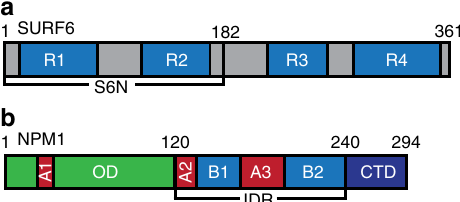
Fig. 1 Structural features of NPM1 and S6N. a SURF6 is a disordered protein which consists of four arginine-rich motifs (R-motifs), R1 – R4 (blue). An N- terminal construct (S6N; residues 1 – 182), which includes two of the R- motifs, R1 and R2, was used in this study. b NPM1 is comprised of an oligomerization domain OD (green), a long intrinsically disordered region (IDR) spanning residues 120 – 240, and a C-terminal nucleotide binding domain (CTD). Acidic and basic tracts in the IDR, A2 and A3 (red), and B1 and B2 (blue), respectively, and the CTD (dark blue), are involved